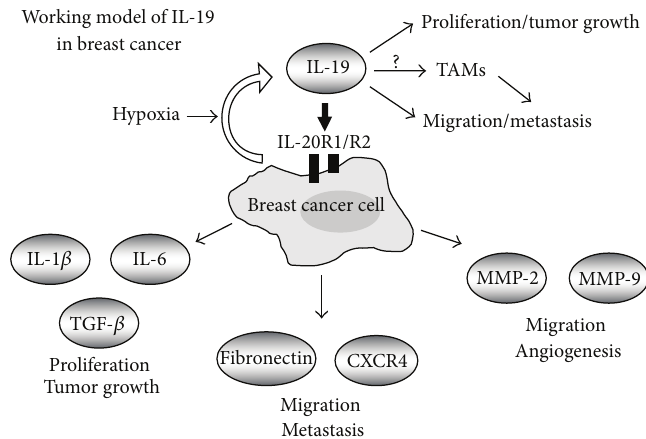
Figure 3: A schematic diagram which shows that IL-19 acts in an autocrine manner. Hypoxia also induces IL-19 production. IL-19 directly promotes the proliferation and migration of breast cancer cells. In addition, IL-19 indirectly induces tumor progression including angiogenesis, tumor growth, and metastasis through MMP2, MMP9, IL-1 𝛽 , IL-6, TGF- 𝛽 , CXCR4, and fibronectin. The hypothesized working model of IL-19 in breast